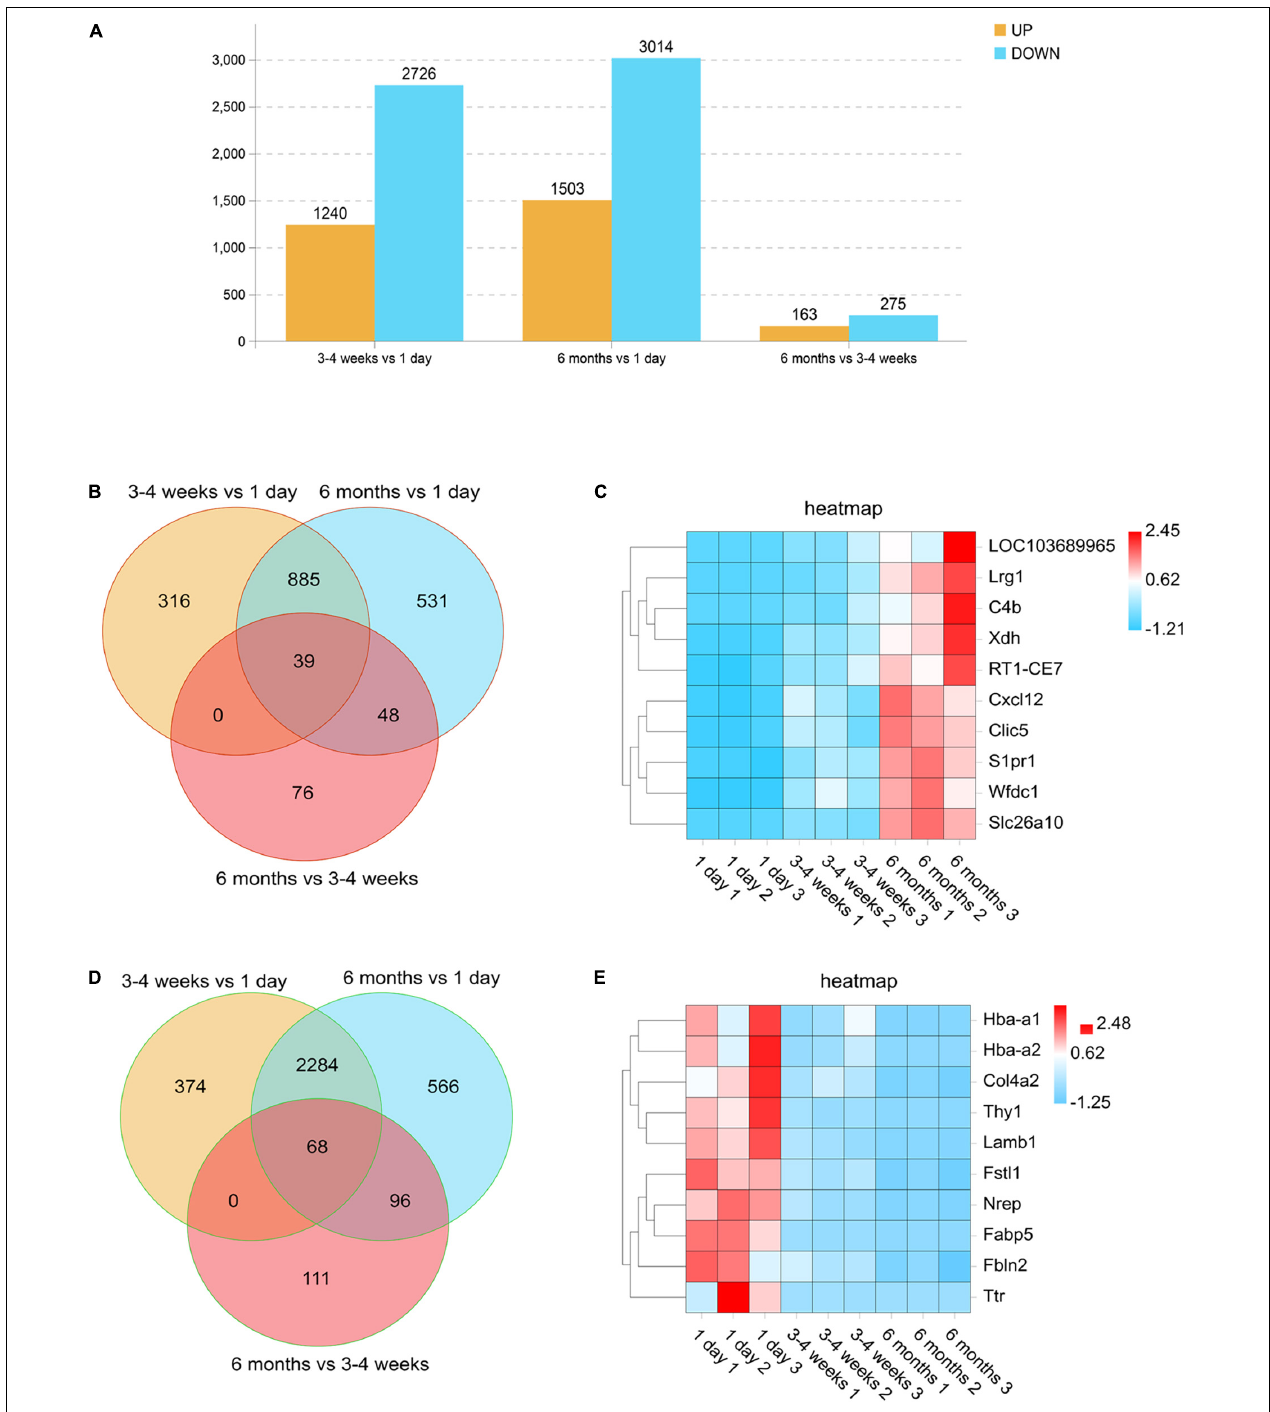
FIGURE 2 | Differentially expressed genes in rat microvessels among the three groups. (A) Histogram analysis comparing the number of upregulated and downregulated genes between each group. Orange represents genes that are up-regulated during growth and development, and blue represents different genes that are down-regulated during growth and development. (B,D) Venn diagrams of the numbers of upregulated (B) and downregulated (D) gene changes in the microvascular endothelial cells observed at all-time points. For each time point, genes were selected as upregulated if they were changed by log2 (fold change) > 2.00, with FDR < 0.05 and downregulated if they were changed log2 (fold change) > –2.00, with FDR < 0.05. (C,E) Heat maps illustrating the transcript abundance in biological triplicates among three microvascular groups for the 10 highest confidence 6-month-old enriched (C) and 1-day-old enriched (E) . The color scale shows the relative expression levels across all samples: red represents an expression level above the mean, and blue represents an expression level lower than the mean.